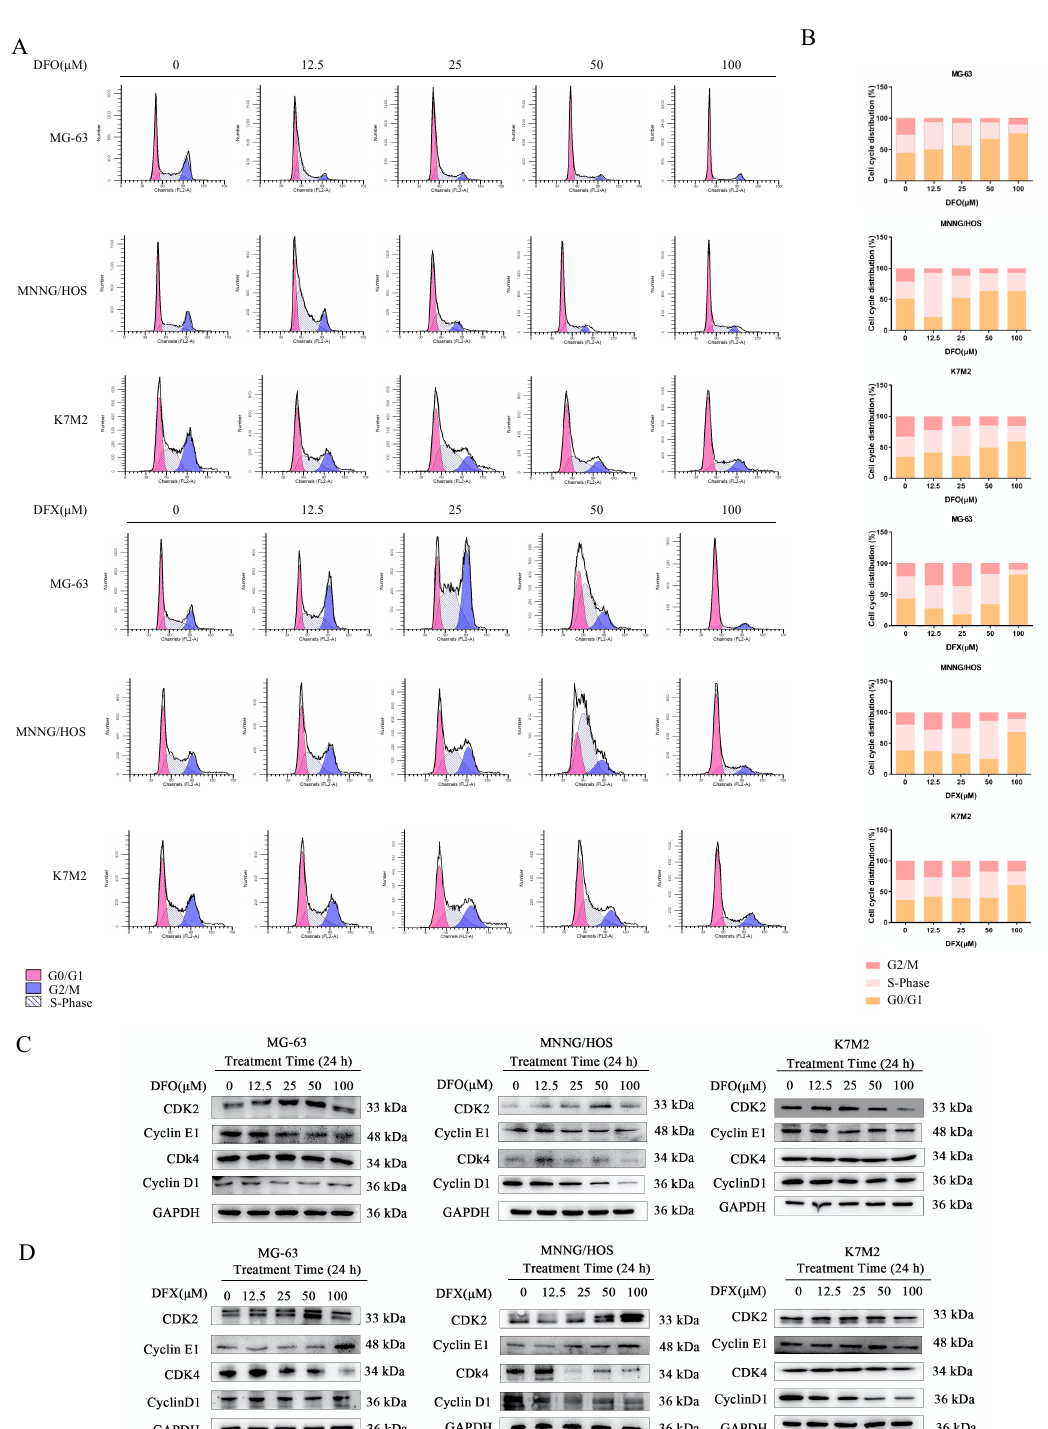
Figure 2. DFO induced G0/G1 cell-cycle arrest, and DFX induced S cell-cycle arrest in osteosarcoma cells. ( A ) The cell-cycle distribution of MG-63, MNNG/HOS and K7M2 cells after treatment with the indicated concentrations of DFO and DFX for 24 h, visualized by PI staining. ( B ) Quantitative analysis of cell-cycle distribution in ( A ). ( C , D ) Protein expression levels of CDK2, cyclin E1, CDK4 and cyclin D1 in MG-63, MNNG/HOS and K7M2 osteosarcoma cells treated with the indicated concentrations of DFO and DFX for 24 h.